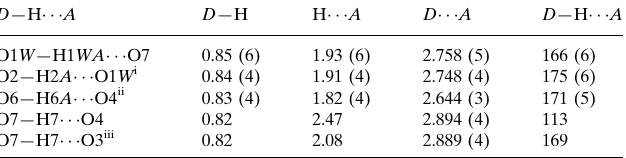
Hydrogen-bond geometry (A˚ , (cid:3)